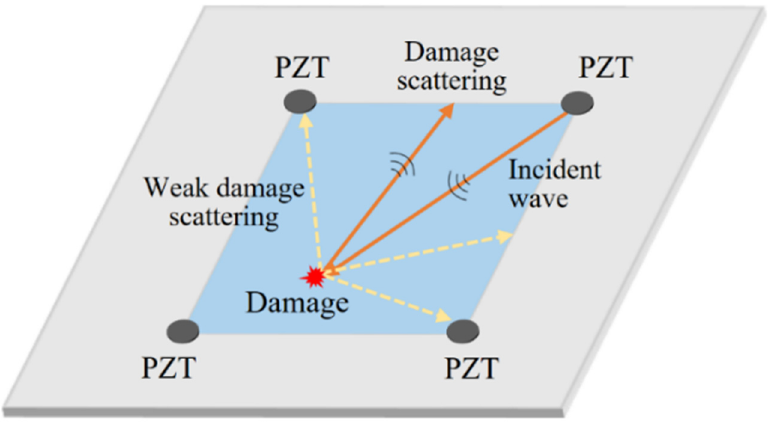
Figure 1. Schematic of angular scattering characteristic of Lamb waves.